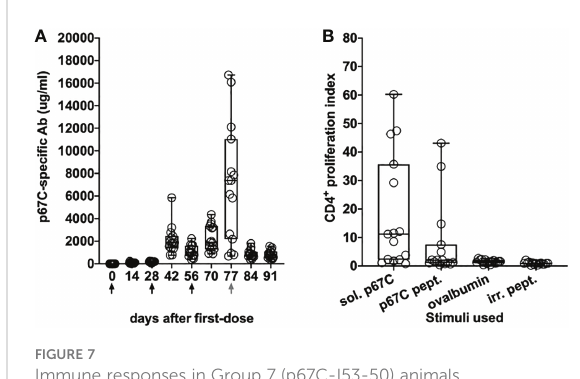
FIGURE 7 Immune responses in Group 7 (p67C-I53-50) animals. (A) Kinetics of Ag-speci fi c IgG titers measured in sera. The days of antigen injection are represented by black arrows, the day of challenge is represented with a gray arrow. (B) p67C-speci fi c CD4 + proliferation increases measured at 2 weeks after the last boost (day 70). Two different stimuli were used: soluble protein (sol. p67C) and a pool of 25-mer p67C overlapping peptides (p67C pept.). Negative stimulus responses are also included: ovalbumin and irrelevant peptides (irr. pept.). The median and the 25 th and 75 th percentile are shown as a box and the min and max values are shown with black bars. Individual animals (n=15) are also presented as black